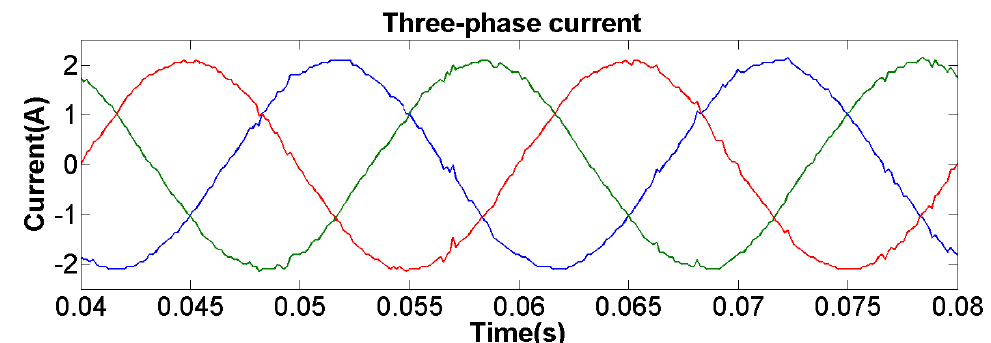
Figure 11. Three-phase current flowing from inverter to grid under no fault condition.